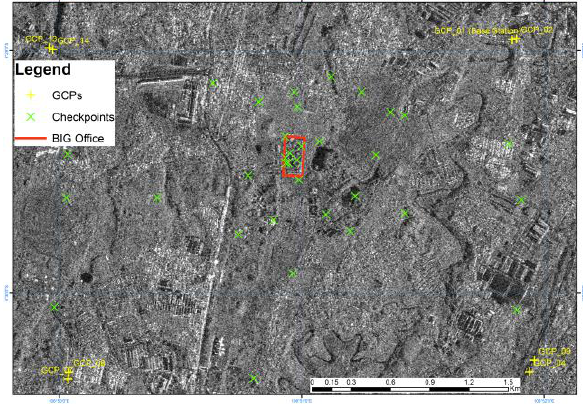
Figure 2. Area of Interest (BIG’s office, Indonesia)